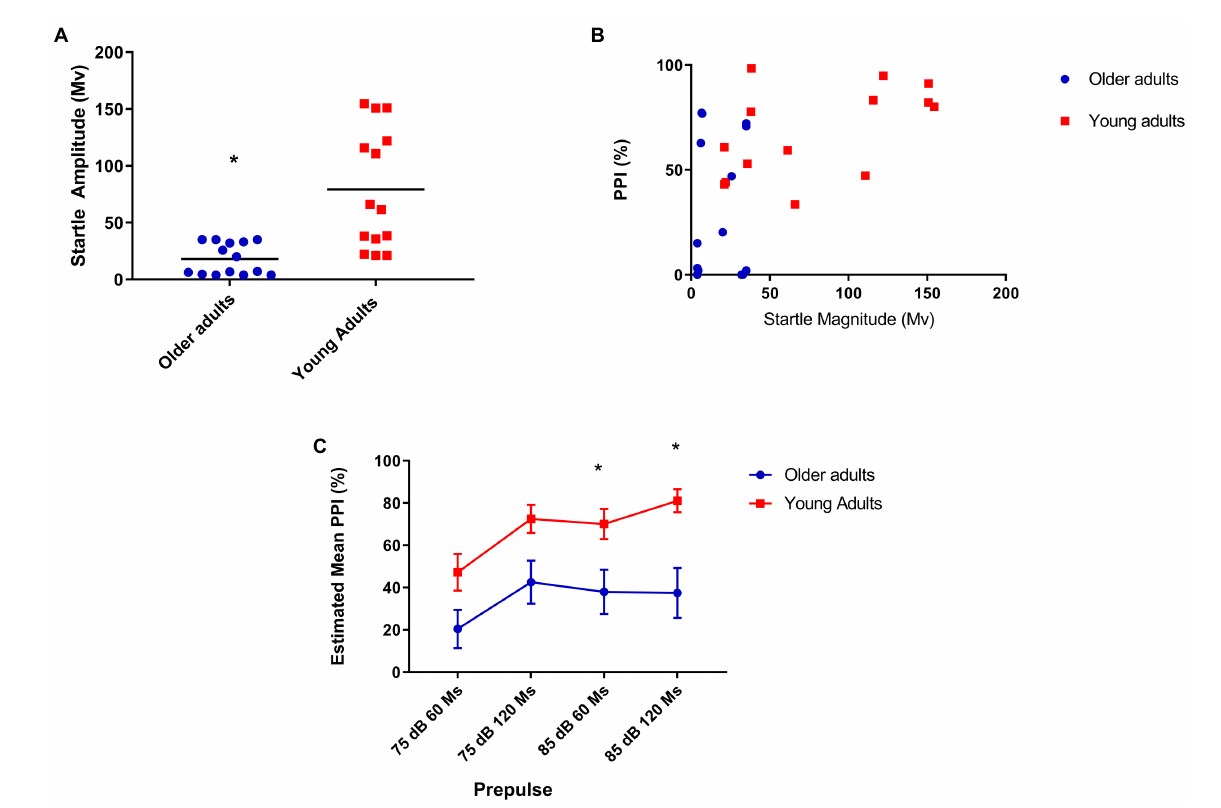
FIGURE 1 (A) Older adults show less startle when compared to young people. Mean startle amplitude: 21.64 (older), 79 (young) U = 26.000 p = 0.001; (B) Moderate positive correlation between prepulse inhibition and startle in the youth group. Older ( N = 14), r = 0.12, p = 0.68; and young ( N = 14), r = 0.53, p = 0.05; (C) Older adults show less inhibition with prepulse of 85 dB at 60 and 120 ms covariating PPI for startle reflex. Older ( N = 14) and younger ( N = 14) Repeated-measures ANCOVA corrected for startle: 85 dB/60 ms = Mean = 26.1 (older), 70.06 (young N = 14)— F [1,25] = 7.93, p =